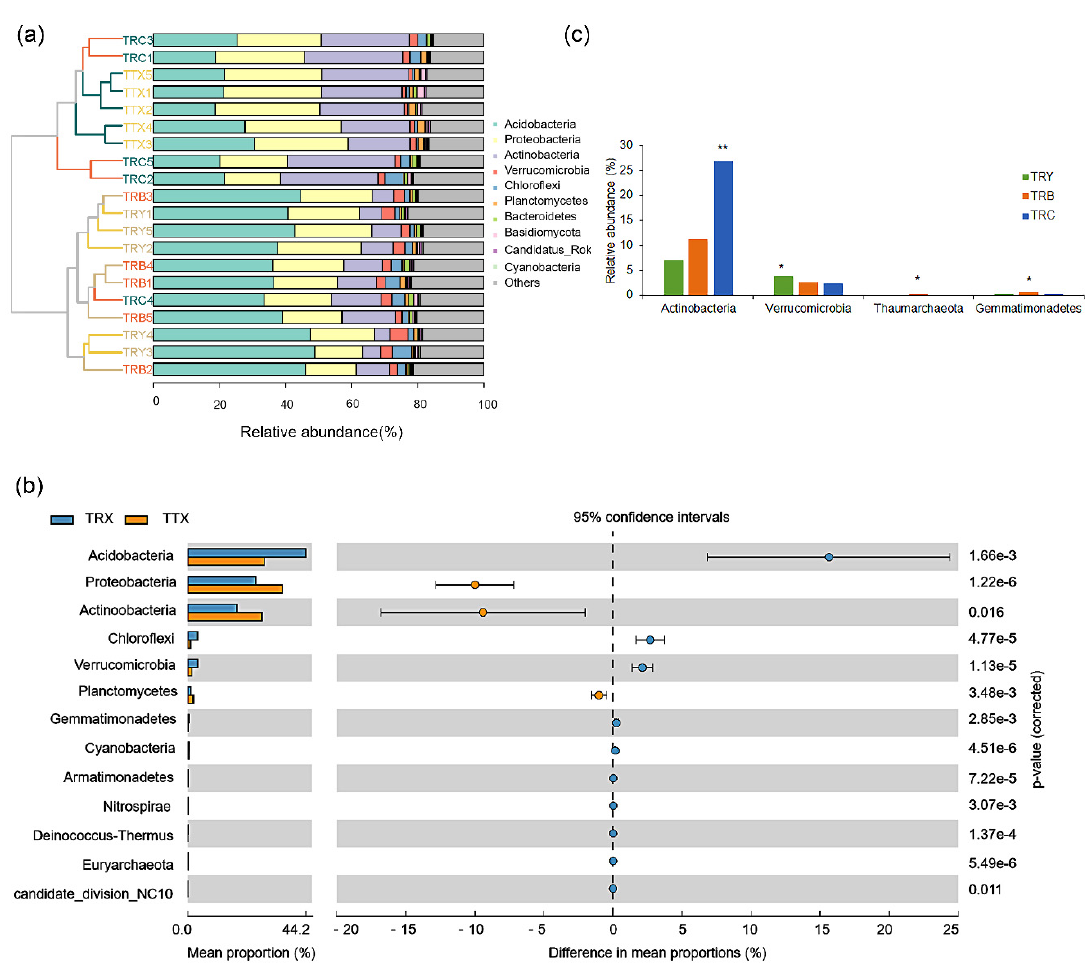
Figure 3. The relative abundance and differences of rhizosphere microbiome (at phylum) in C. henryi . ( a ) Relative abundance (%) of the major taxonomic distribution at Phylum. ( b ) The pairwise comparison difference at phyla were calculated with Welch’s t -test. ( c ) The multiple comparisons comparison difference at phyla were calculated with Kruskal–Wallis rank-sum test. * Correlation is significant at p < 0.05; ** Correlation is significant at p < 0.01; TRY, TRC, and TRB, three cultivated varieties of plantation; TTX, natural forest; TRX, plantation.